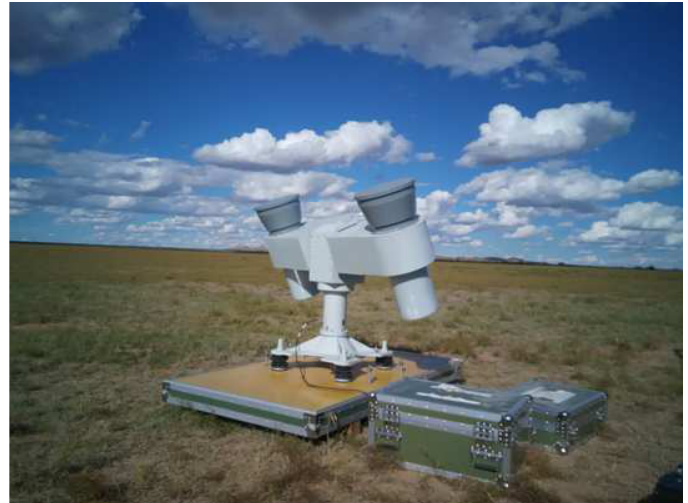
Figure 4. One of the polarimetric active radar calibrators (PARCs) deployed at the grassland for the GF-3 experiment.